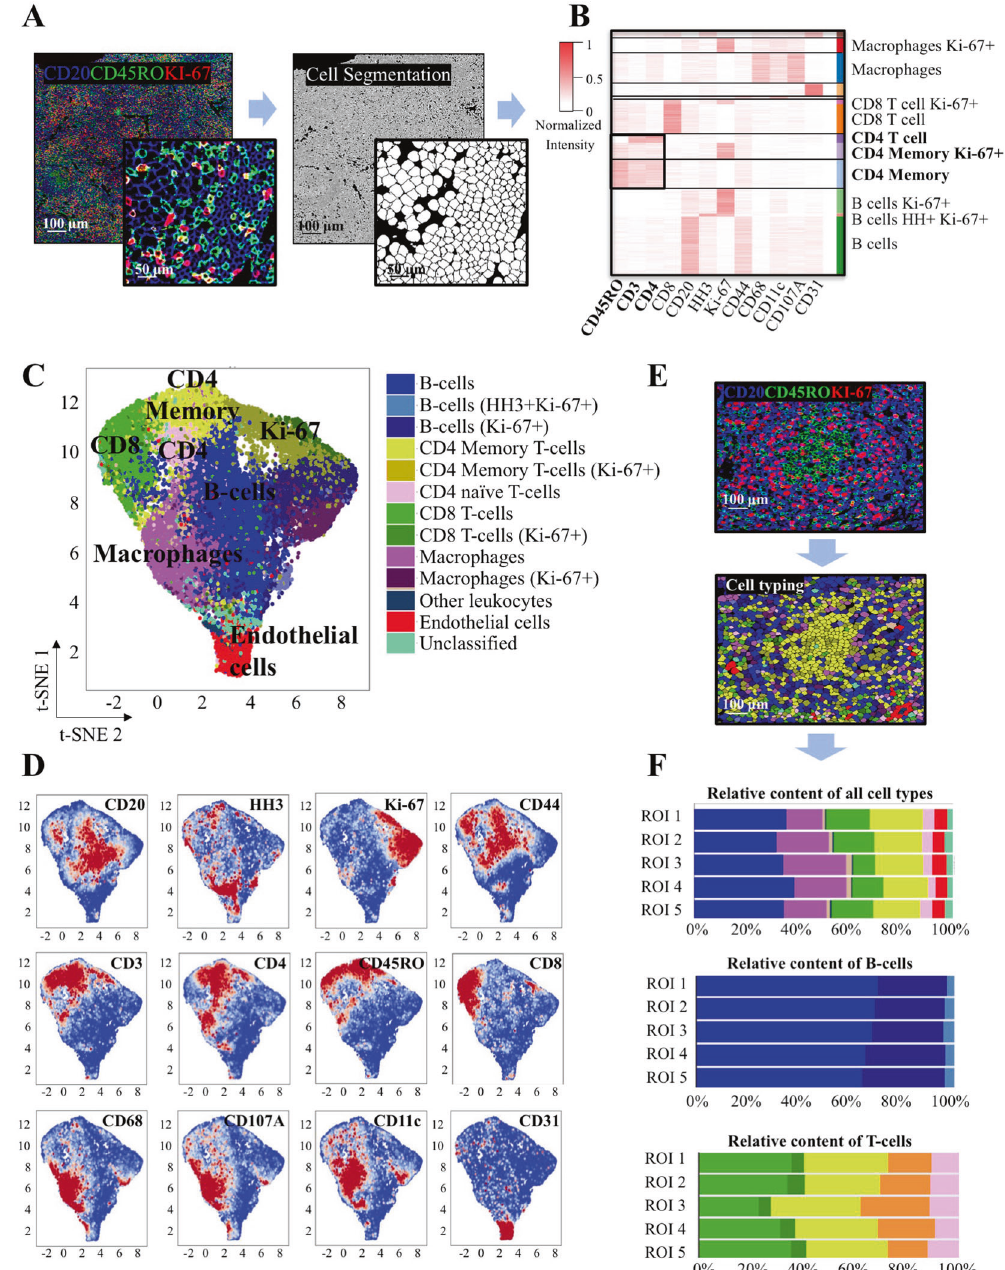
Fig. 4 Tumor characterization of follicular lymphoma. A Representative images showing the correspondence between composite fl uorescence and cell segmentation. B Heatmap showing marker expression within each identi fi ed cell cluster. Values are depicted in a colorimetric scale from red (high) to white (low). C t -SNE plot of cell clusters derived from 5 regions of interest (ROI). D t -SNE plots showing expression of indicated markers from C . Values are depicted in a colorimetric scale from red (high) to blue (low). E Representative images showing that intrafollicular CD20-CD4 + CD45RO + cells correspond to CD4 + memory T cells. F Bar graphs showing similar frequency of the indicated cell subsets among the fi ve